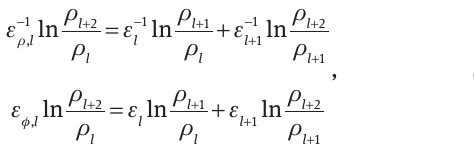
= 95 nm. (B) Anisotropic material properties (dielectric function) of the ideal nano- b